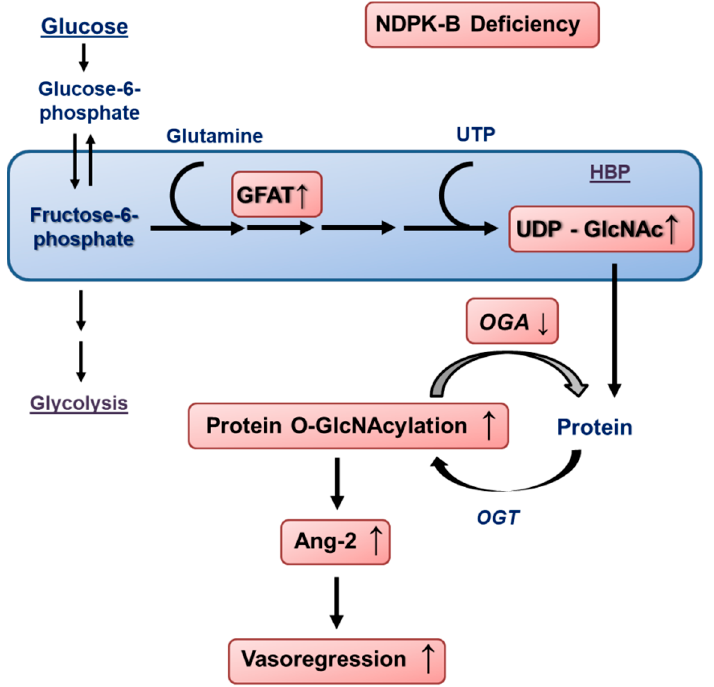
Figure 7. Schematic overview of the activation of the HBP and enhanced protein O-GlcNAcylation caused by the loss of NDPK-B in the endothelium and the subsequent upregulation of Ang-2. Loss of NDPK-B increases the HBP flux via the upregulation of GFAT, leading to an increase in UDP-GlcNAc production. The concomitant reduction in OGA activity results in an accumulation of O-GlcNAcylated proteins, driving the upregulation of Ang-2 in the microvascular endothelium of the retina, thereby inducing vasoregression.